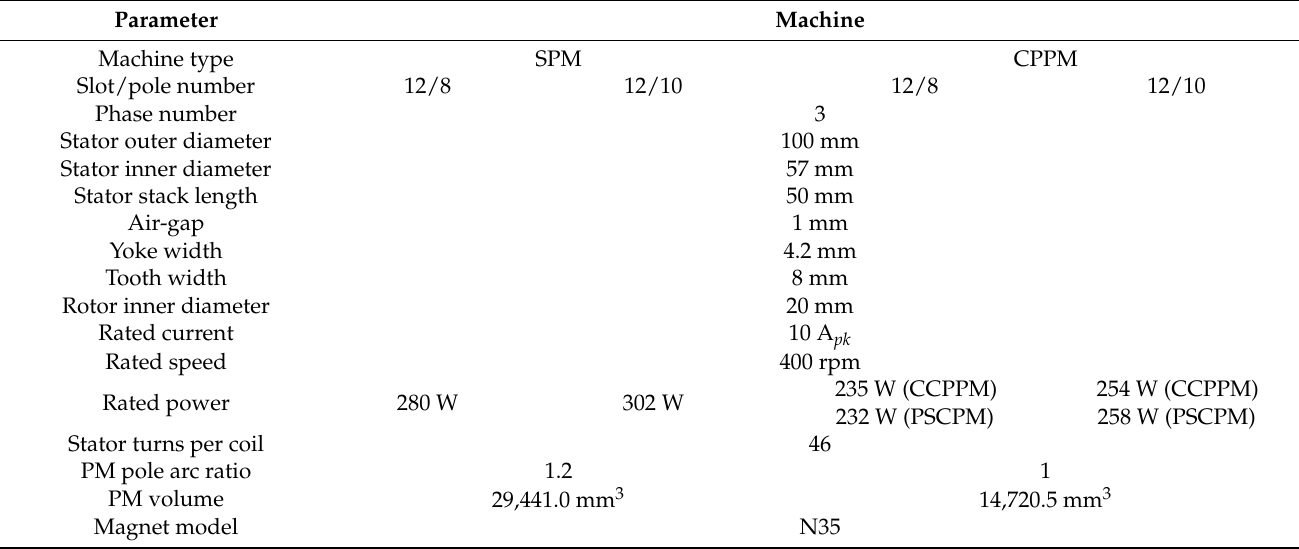
Figure 2. Models for analysis in this paper. ( a ) Torque characteristics for 12s8p CCPPM machine. ( b ) Torque characteristics for 12s10p CCPPM machine. Table 1. Key Design Parameters of Analyzed Machines.